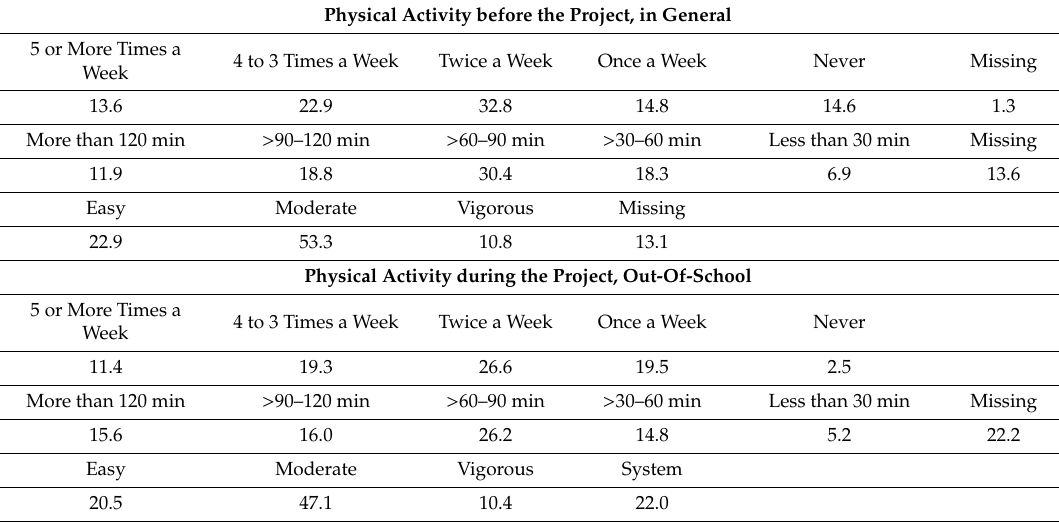
Table 2. Changes in the amount physical activity before and during the